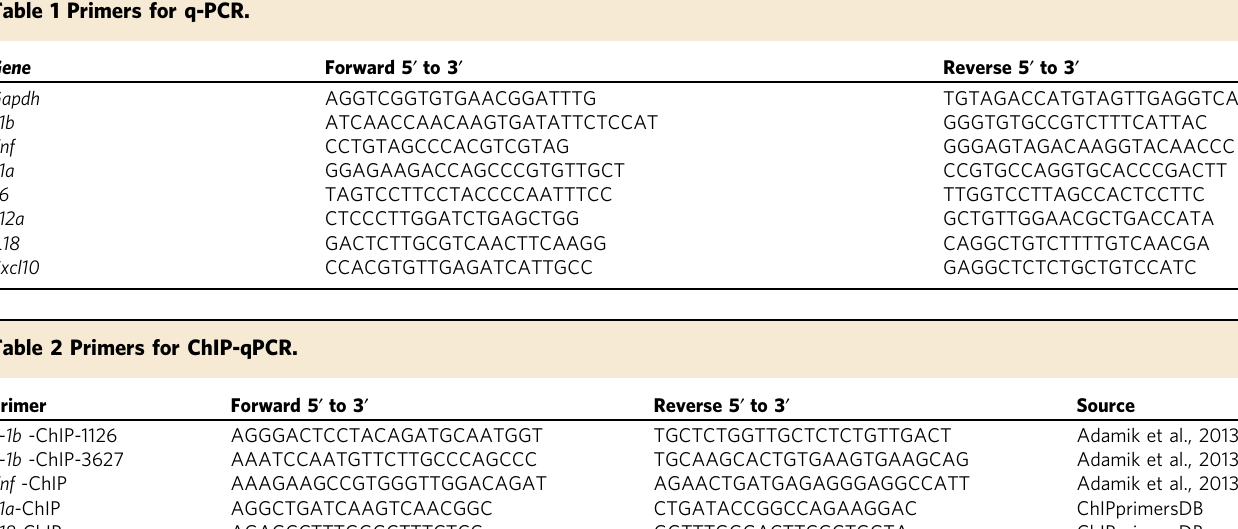
Table 1 Primers for q-PCR.